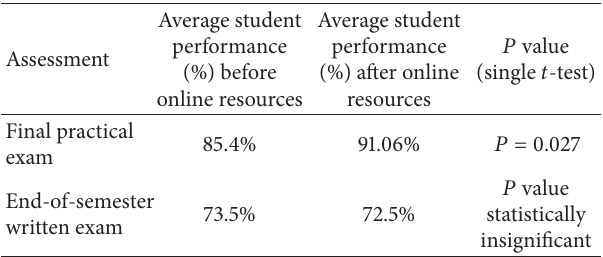
Table 5: Showing a summary of the overall students’ performance in all assessment tasks before and after using the online resources ( 𝑃 < 0.05 was used to establish